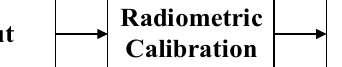
Figure 2. Preprocessing flowchart.